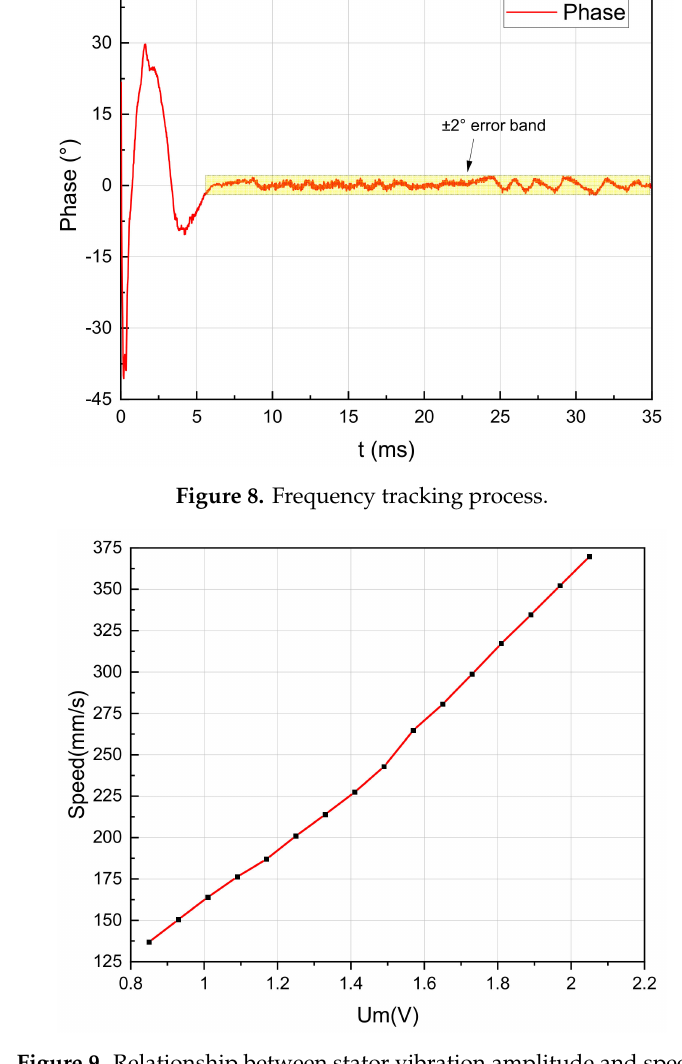
Figure 9. Relationship between stator vibration amplitude and